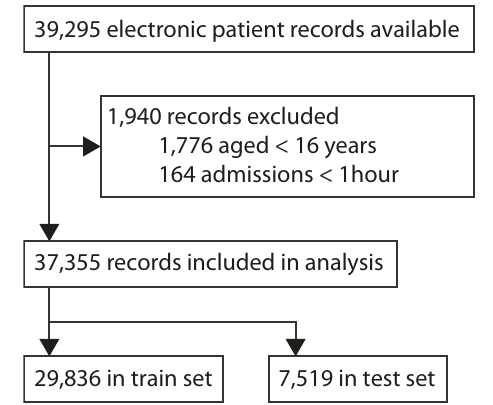
Fig. 1 Illustration of the cohort selection procedure. The raw dataset contained electronic patient record data from 39,295 ICU admissions. 1940 records were excluded because the patients were too young (<16 years) or the admissions were too short (<1 h). The remaining 37,355 records were split into a training set (80%; n = 29,836 admissions) and a test set (20%; n = 7519 admissions).